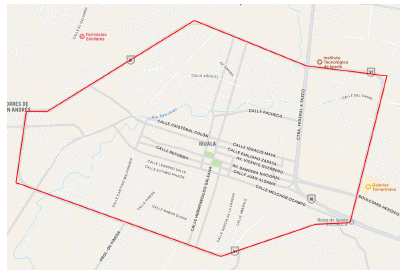
Figure 24. The peripheral avenue of Iguala is shaped as an 8-sided polygon